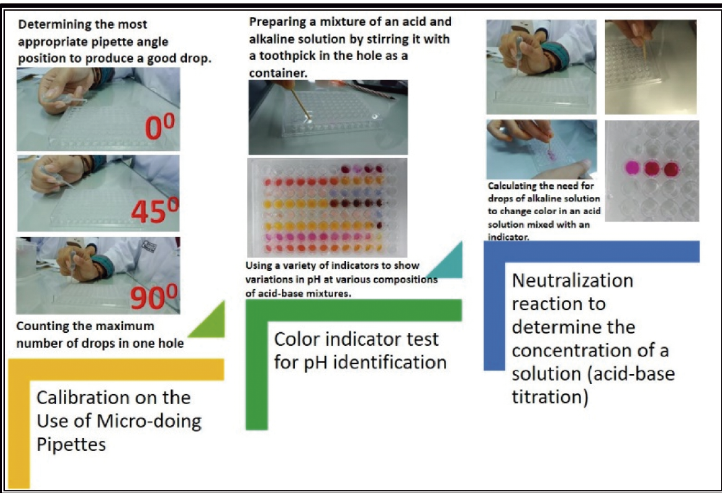
Figure 3. Practical activities introduced to teachers and students